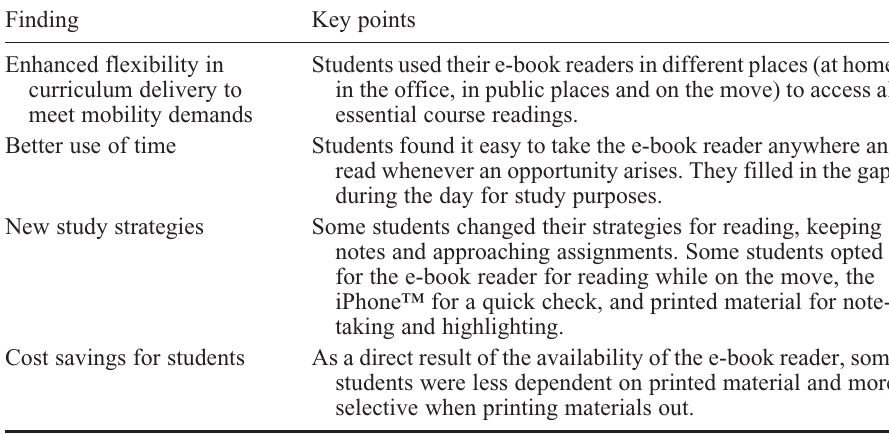
Table 7. Summary of key advantages of e-book readers in curriculum delivery. Finding Key points